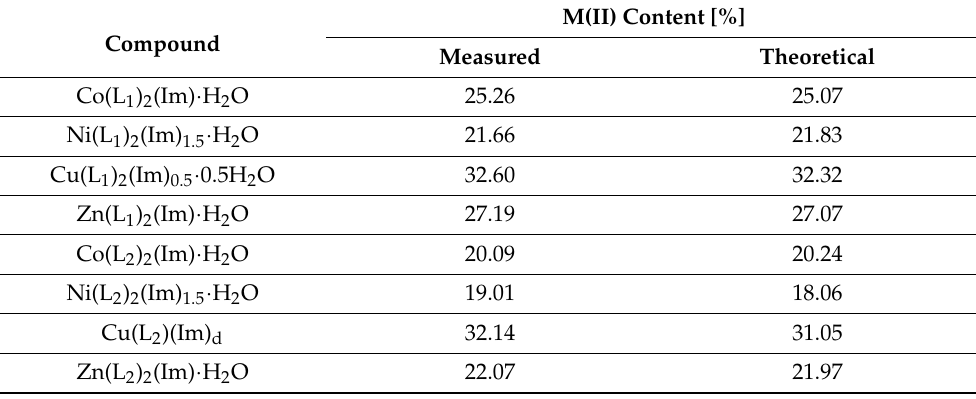
Table 2. Measured and theoretical percentage M(II) contents for investigated compounds.